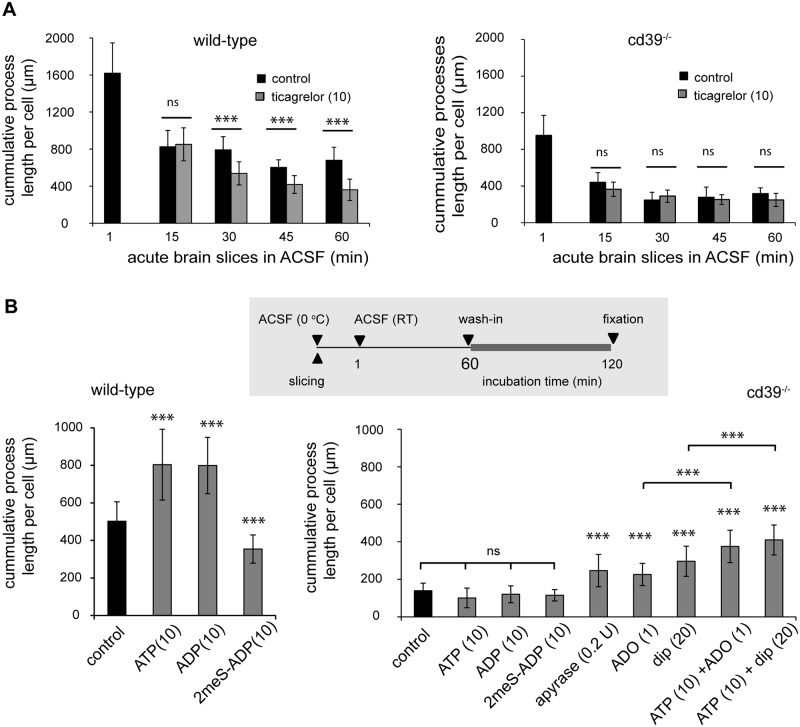
In acute brain slices, microglial process growth is promoted by constitutive activity of P2Y12 receptors and availability of extracellular adenosine.(A) As described in the legend to Fig 3, the cumulative process length of microglia was measured 1 minute and then every 15 min after acute slice preparation. In comparison to control (black bars) conditions, constitutive inhibition of P2Y12 receptors with ticagrelor (grey bars, 10 μM) significantly decreased the cumulative length of microglial processes in acute brain slices from wild-type (left) but not from cd39-/- mice (right). (B) On top, the scheme indicates the experimental arrangement. In wild-type microglia (left) but not in cd39-/- mice (right), ATP (10 μM) and ADP (10 μM) increased the cumulative length of microglial processes in comparison to control (black bars) slices. 2meS-ADP (10 μM) even decreased process length in acute brain slices of wild-type but not of cd39-/- mice. Application of apyrase (0.2U), adenosine (ADO, 1 μM), dipyridamole (dip, 20 μM), and a combined application of ATP and adenosine or ATP and dipyridamole increased the cumulative length of microglial processes in cd39-/- mice in comparison to control (black bars) conditions. ns denotes p > 0.5 and *** denotes p < 0.001.